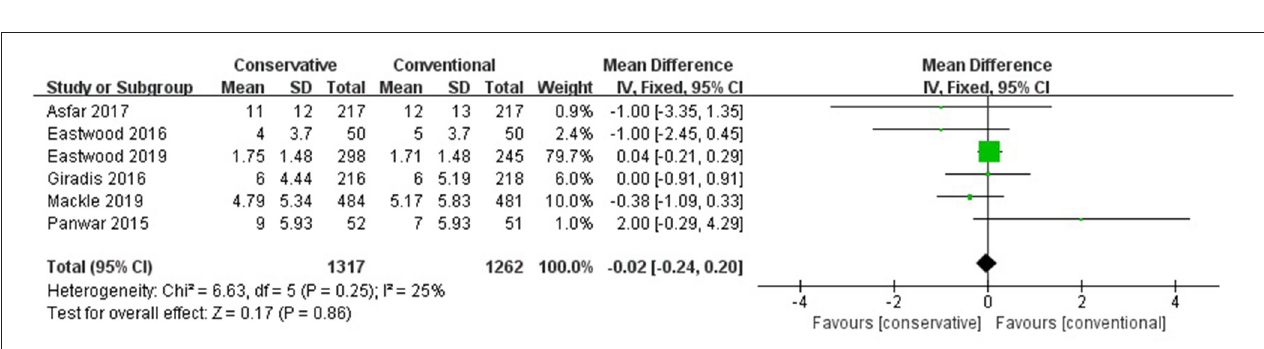
88–92%, and the same result was found (RR 1.03, 95%